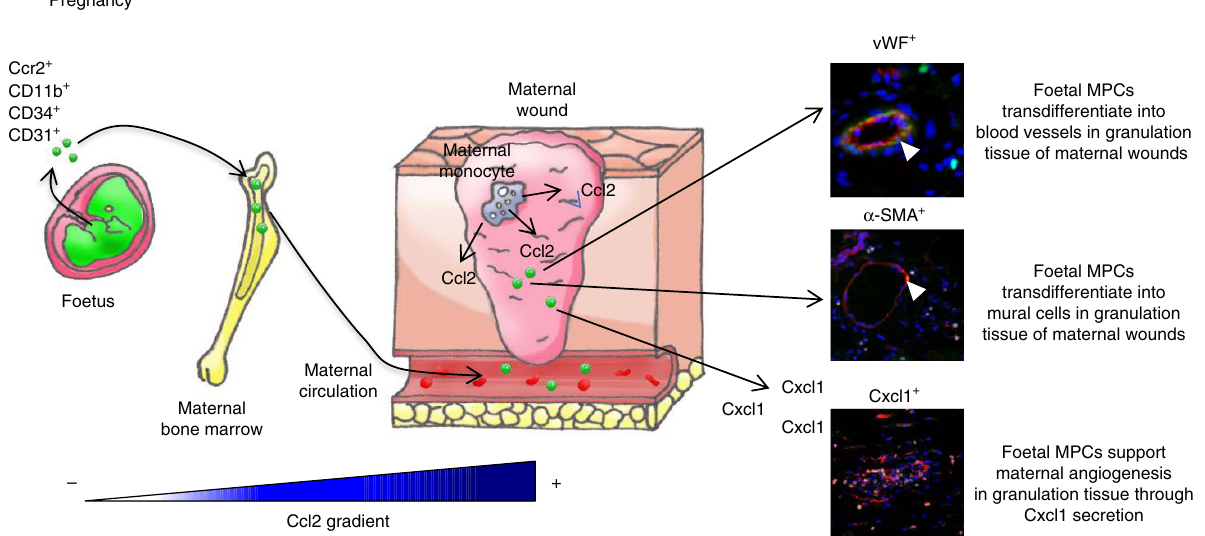
Figure 7 | Mechanistic diagram of the role of fetal MPCs in maternal wound healing. During pregnancy or postpartum, cutaneous wound monocytes and endothelial cells secrete Ccl2. This chemokine triggers the early recruitment of CD11b þ CD34 þ CD31 þ fetal cells from bone marrow to maternal wounds. Once these cells have reached the wound bed, they will differentiate into fetal-derived endothelial and mural cells. In addition, fetal cells secrete specific angiogenic signals such as Cxcl1 that increase maternal-derived angiogenesis. Overall, these mechanisms enhance maternal skin healing in pregnancy or postpartum.